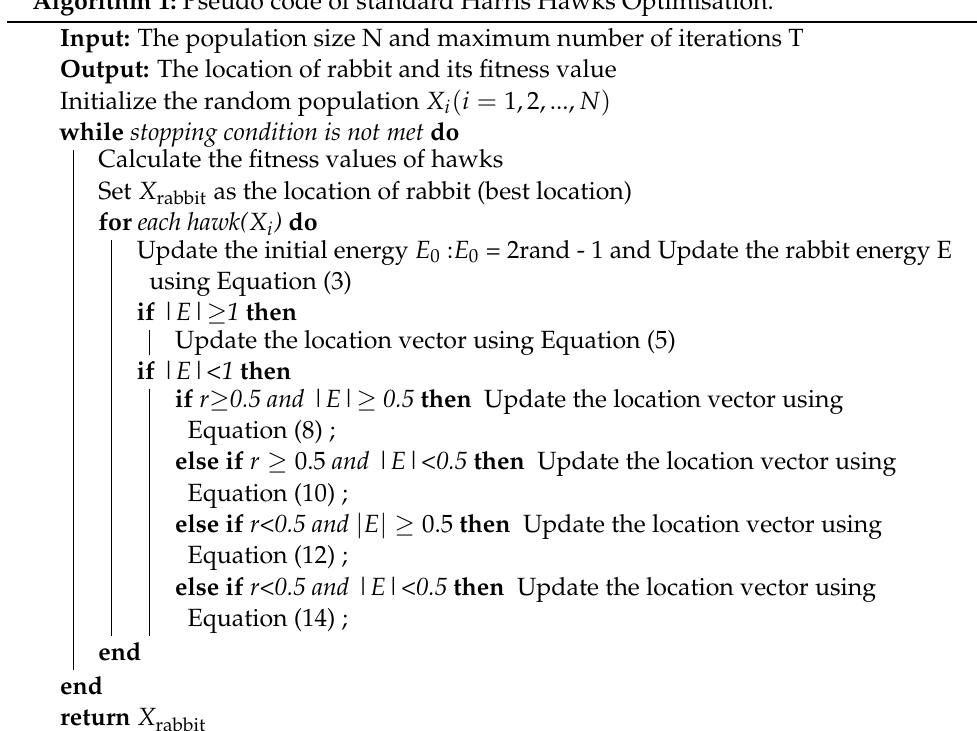
Algorithm 1: Pseudo code of standard Harris Hawks